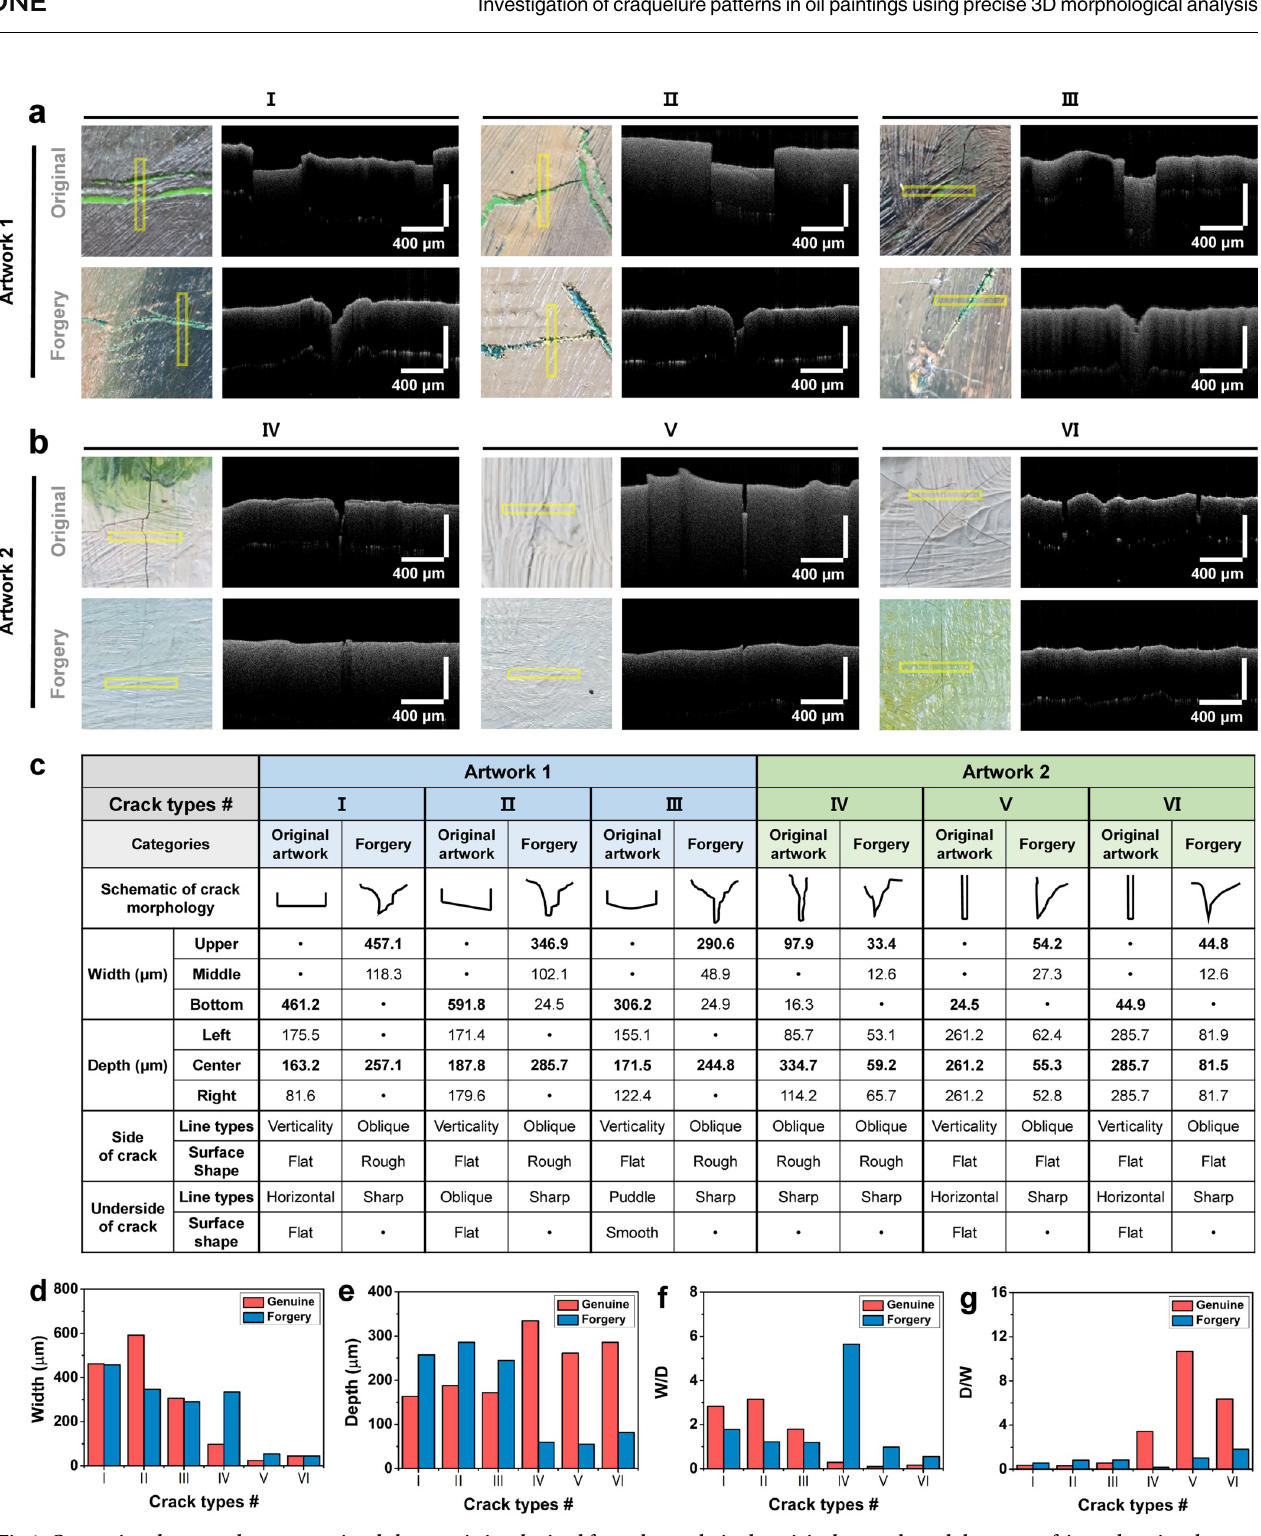
Fig 4. Comparison between the cross-sectional characteristics obtained from the cracks in the original artworks and the counterfeit cracks using the OCT system. (a) Cracks in Artwork 1 caused by the small amount of medium in the upper layer but formed with a wide rectangular shape. The forged cracks in Artwork 1 appear similar in depth to the original cracks, but unlike the original cracks, which are rectangular, they have an inverted triangle shape. (b) Original cracks in Artwork 2 caused by the small amount of medium in the under layer. The cracks were formed in a thin and very deep rectangular shape. Unlike the original cracks, the forged cracks in Artwork 2 are very shallow in depth. (c) Quantitative analysis of the OCT cross-section images of the original and forged cracks of Artwork 1 and Artwork 2 . The representative values of the dimensions of the original and forged cracks selected for analysis, were compared by (d) width, (e) depth, (f) width/depth, and (g) depth/width. https://doi.org/10.1371/journal.pone.0272078.g004 PLOS ONE | https://doi.org/10.1371/journal.pone.0272078 July 28,